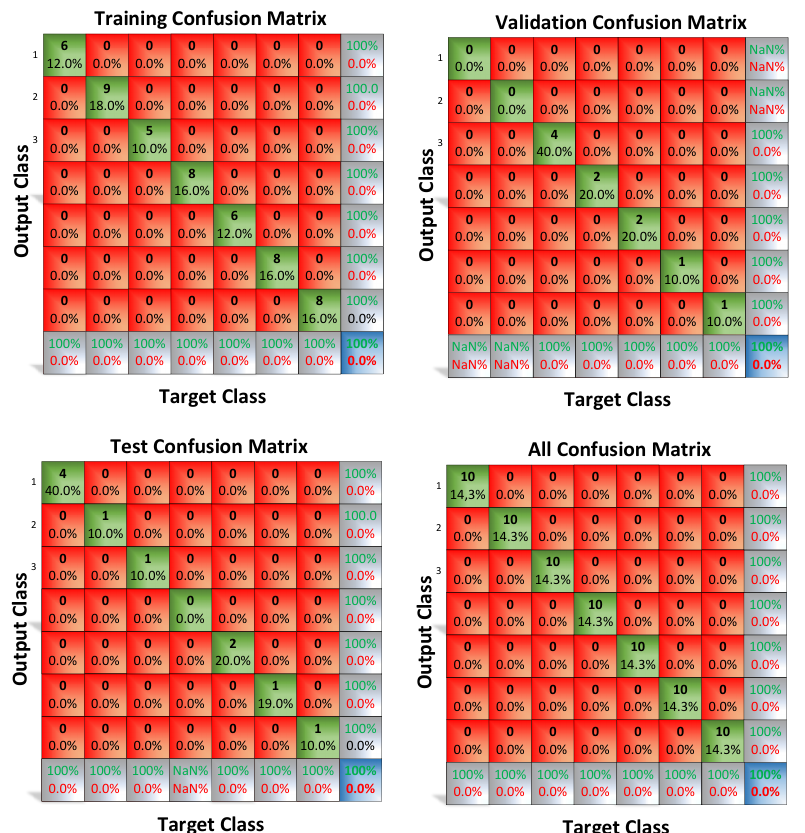
Figure 4. Training confusion matrix for sorting unifloral honeys.